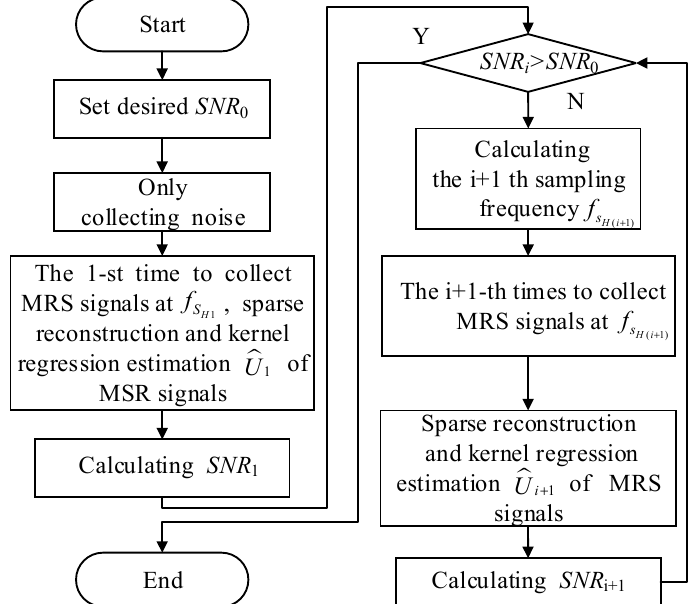
Figure 2. Flowchart for implementation of the intensive sampling sparse reconstruction and kernel regression estimation (ISSR-KRE) approach.